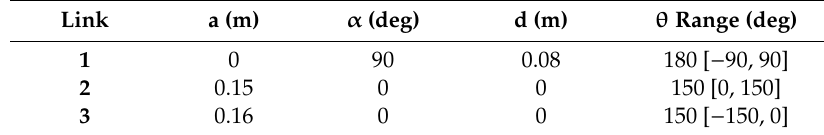
Figure 2. The D–H frame of the manipulator. Table 2. D–H parameters of the manipulator.